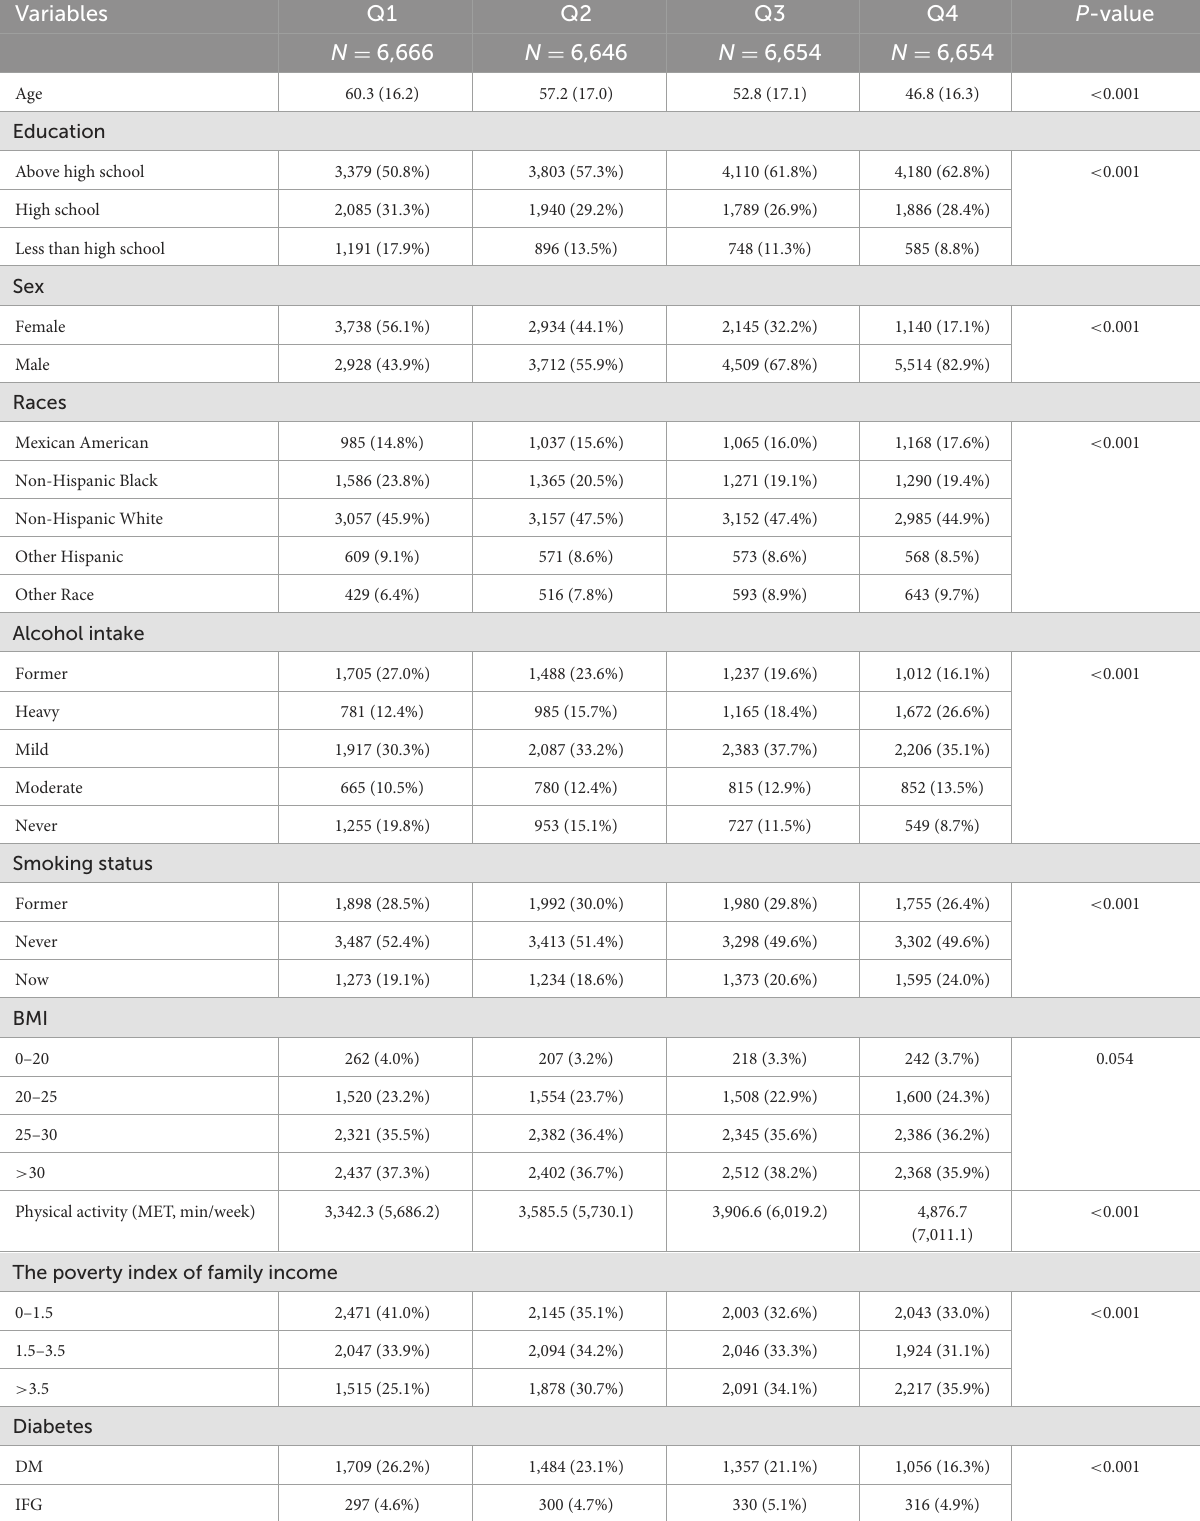
TABLE 1 The characteristics of participants (NHANES